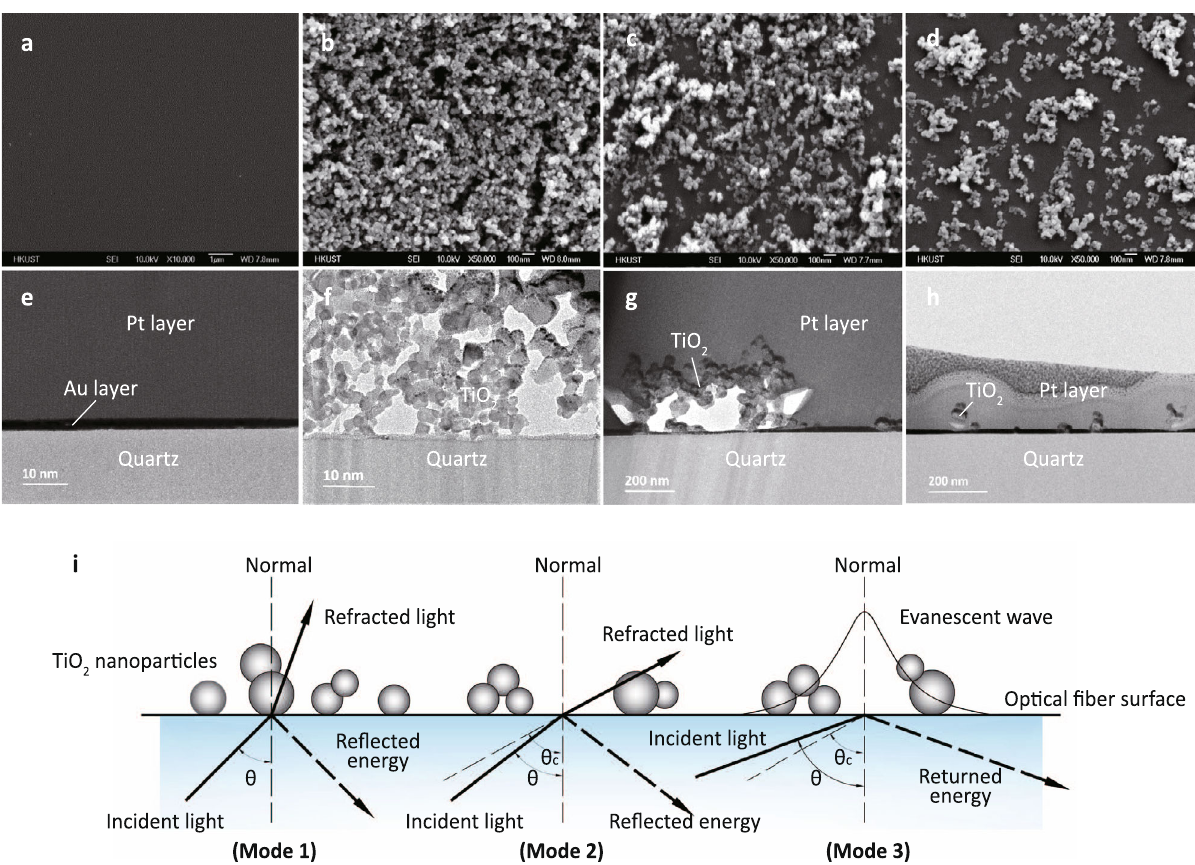
Fig. 2 Characterization and analysis of the uncoated quartz optical fi bers and three TiO 2 -QOFs. a – d Scanning electron microscope (SEM) surface images of the uncoated optical fi ber, TiO 2 -QOF-High, TiO 2 -QOF-Med, and TiO 2 -QOF-Low, respectively; e – h transmission electron microscopy (TEM) images of cross-sectional morphologies of the uncoated optical fi ber, TiO 2 -QOF-High, TiO 2 -QOF-Med, and TiO 2 -QOF-Low, respectively, in which an Au layer was deposited to capture images during the focus ion beam operation and a Pt layer was deposited to protect the TiO 2 coating layers from damaging by focus ion beams; and i conceptualized images of TiO 2 coating layers on the quartz optical fi ber surfaces and proposed three light propagation modes at the